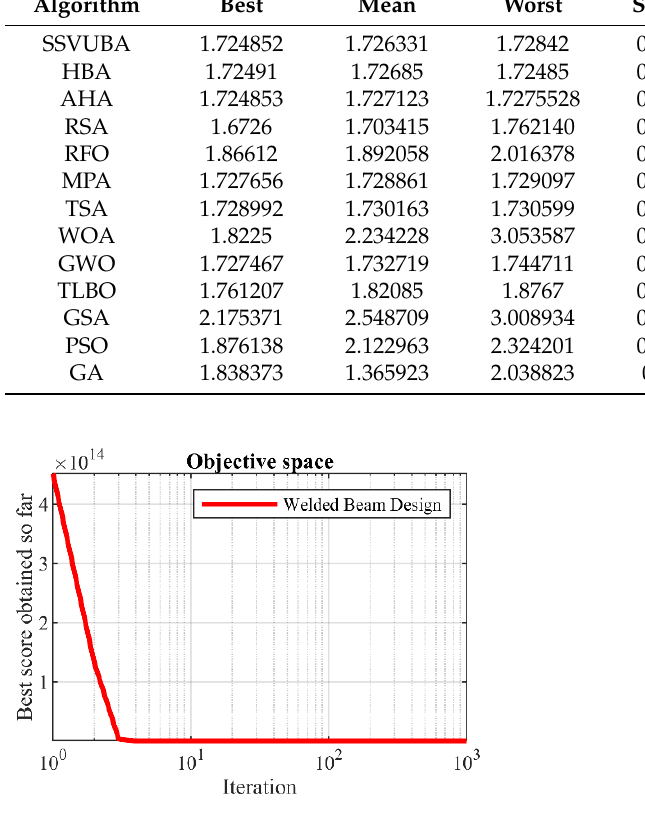
Figure 13. SSVUBA’s performance convergence curve for the welded beam design.